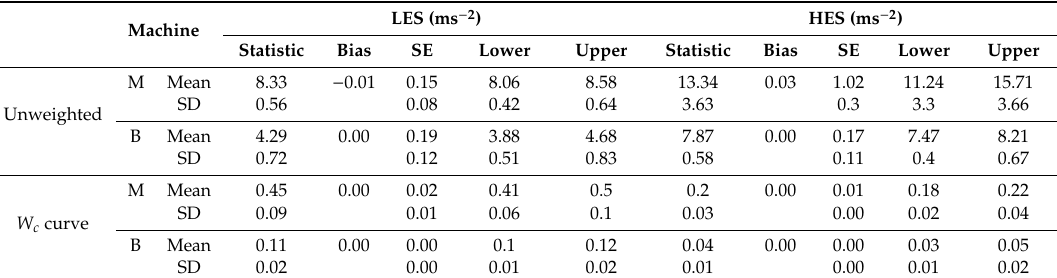
Table 3. The bootstrap method (1000 bootstrap samples) applied to the vibration total values (VTVs) (unweighted and after the application of W c weighting curve) produced by mist blowers and blowers on the operators’